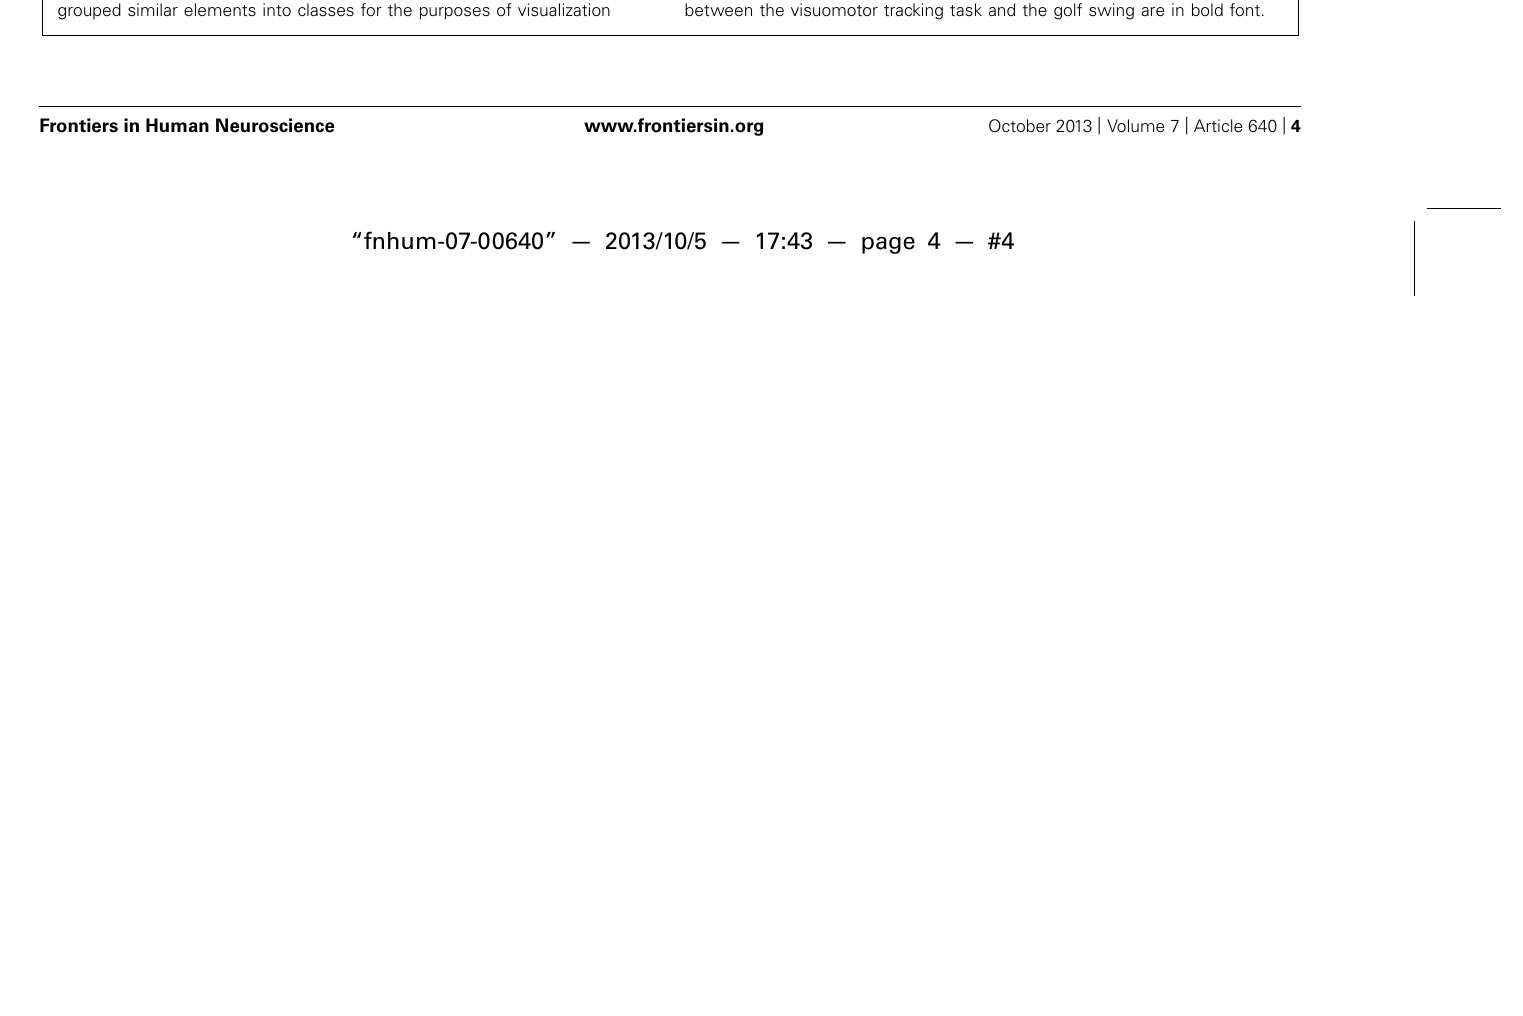
FIGURE 2 |Task decomposition diagrams for two training paradigms, (A) the visuomotor tracking task of Landi etal. (2011), and (B) a golf swing which we presume was a major part of golf training (Bezzola etal., 2011). Sub-tasks of the main activity are shown with boxes. We have grouped similar elements into classes for the purposes of visualization